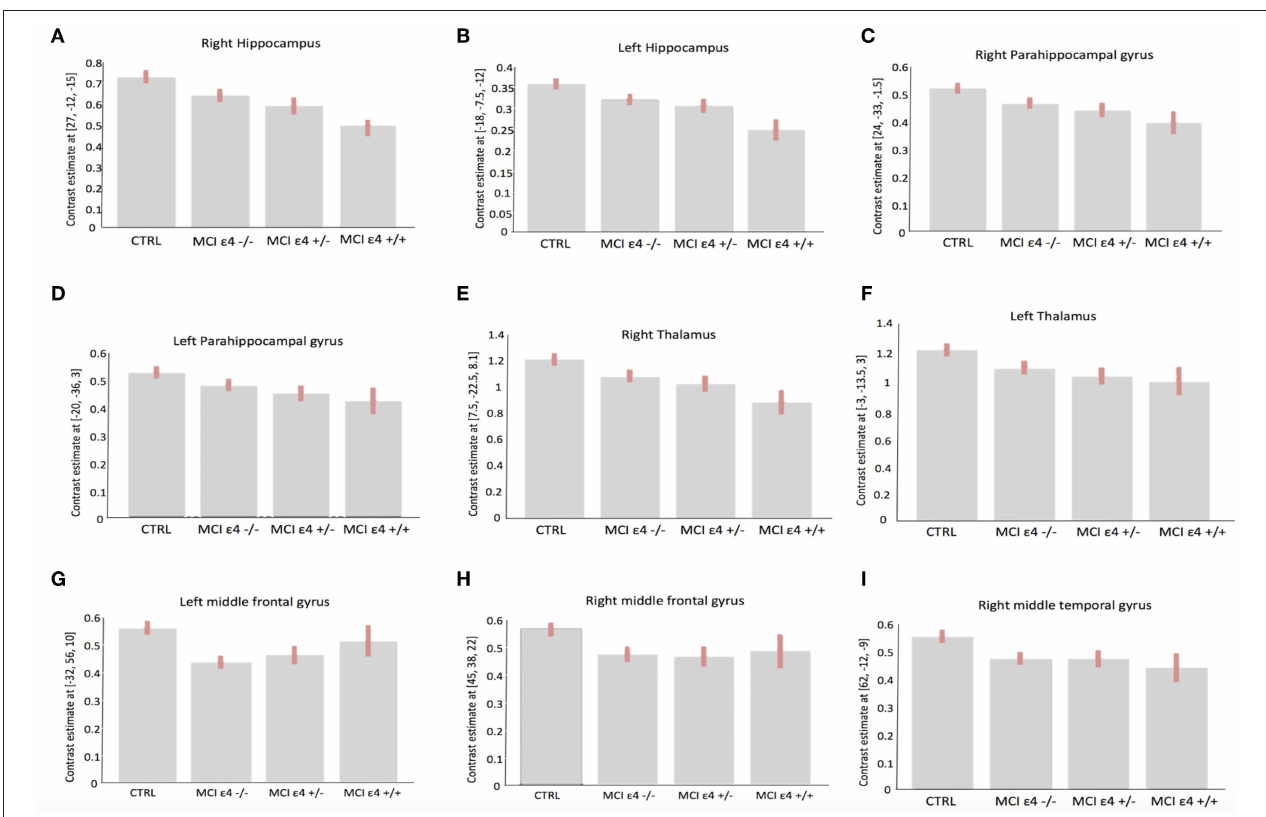
FIGURE 2 | Plots depicting mean differences among groups within region of statistical significance in VBM analysis: right (A) and left (B) hippocampus; right (C) and left (D) parahippocampal gyrus; right (E) and left (F) thalamus, left (G) and right (H) middle frontal gyrus, and right middle temporal gyrus (I) .